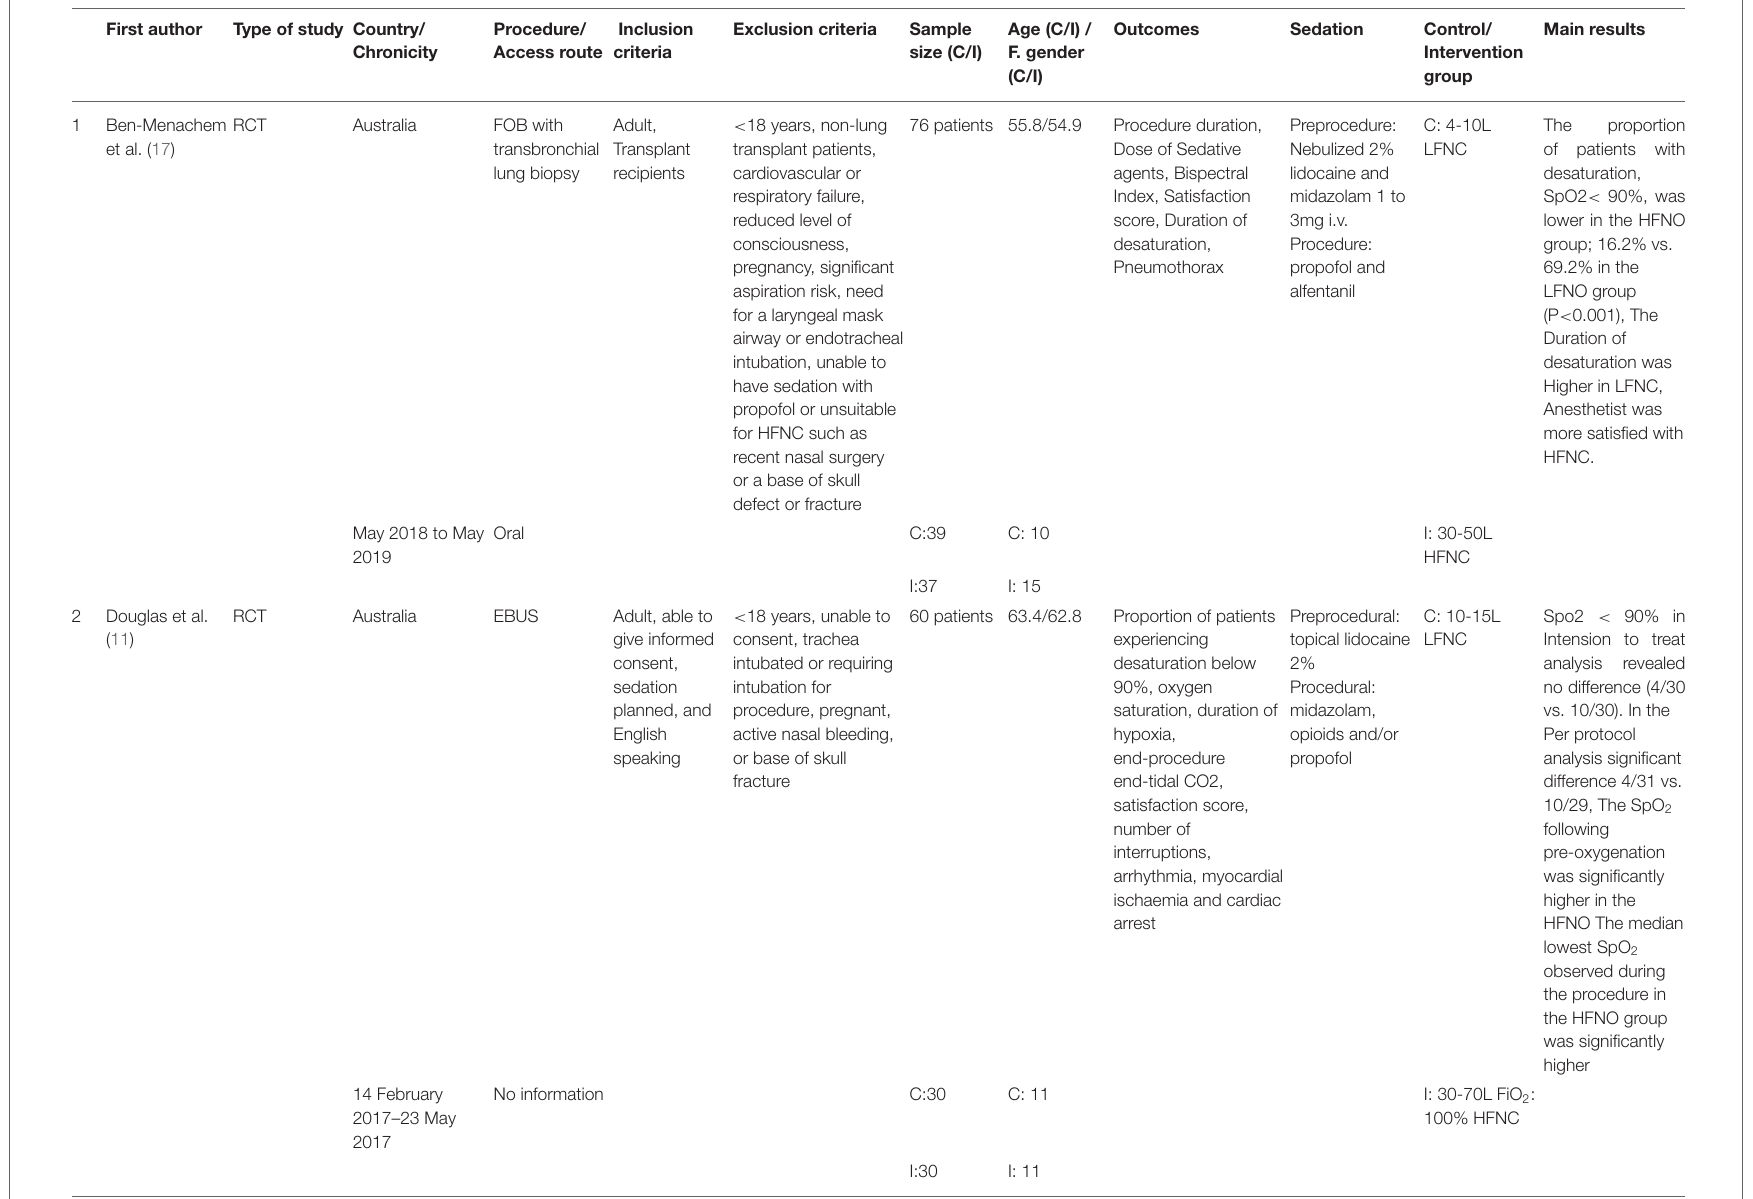
TABLE 1 | Characteristics of analyzed